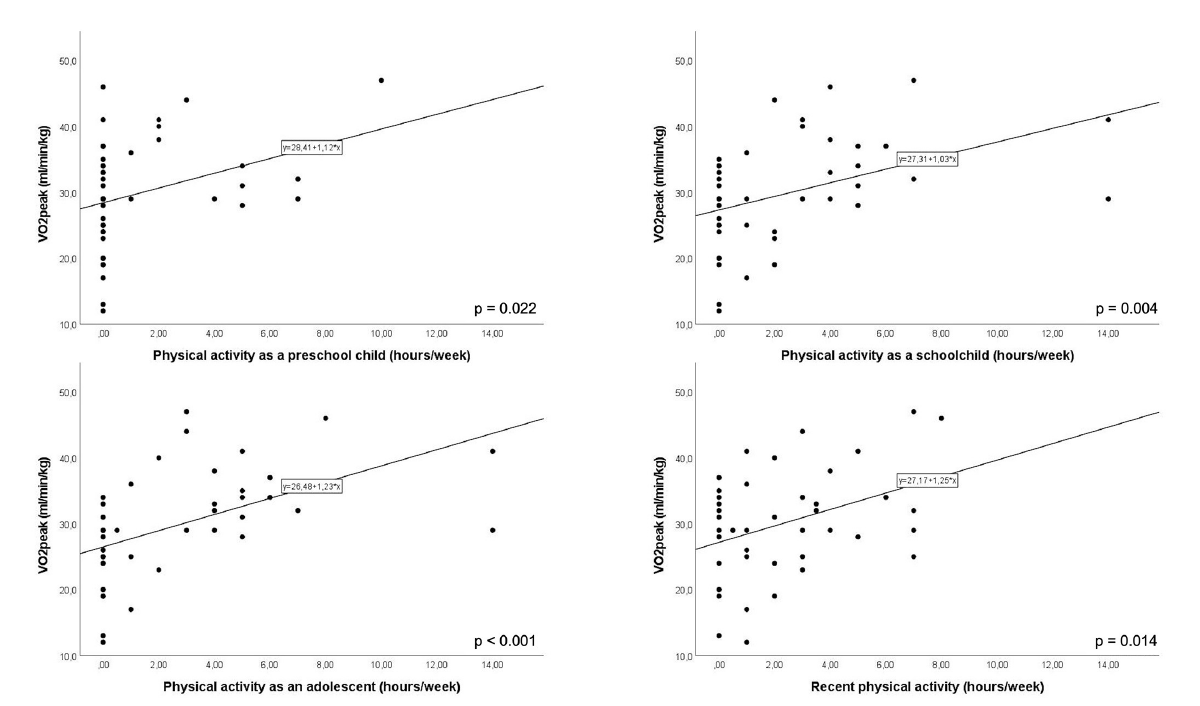
FIGURE1 Correlation between hours of physical activity per week as a preschool child, as a schoolchild, as an adolescent and recently. Each of these correlations reached significance ( p -values for each correlation are depicted in the lower right-hand corner).